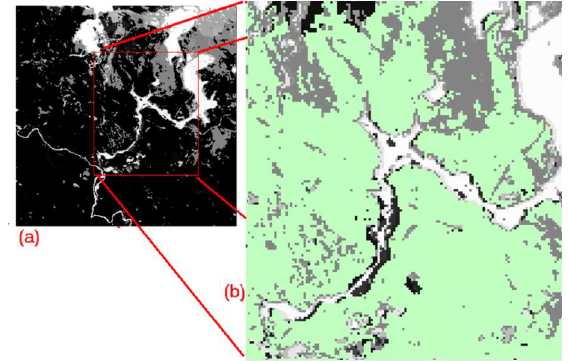
Figure 4 – Binary encoding of the Córrego do Feijão catchment. (a) binary encoded image; (b) zoom of the catchment with null values in